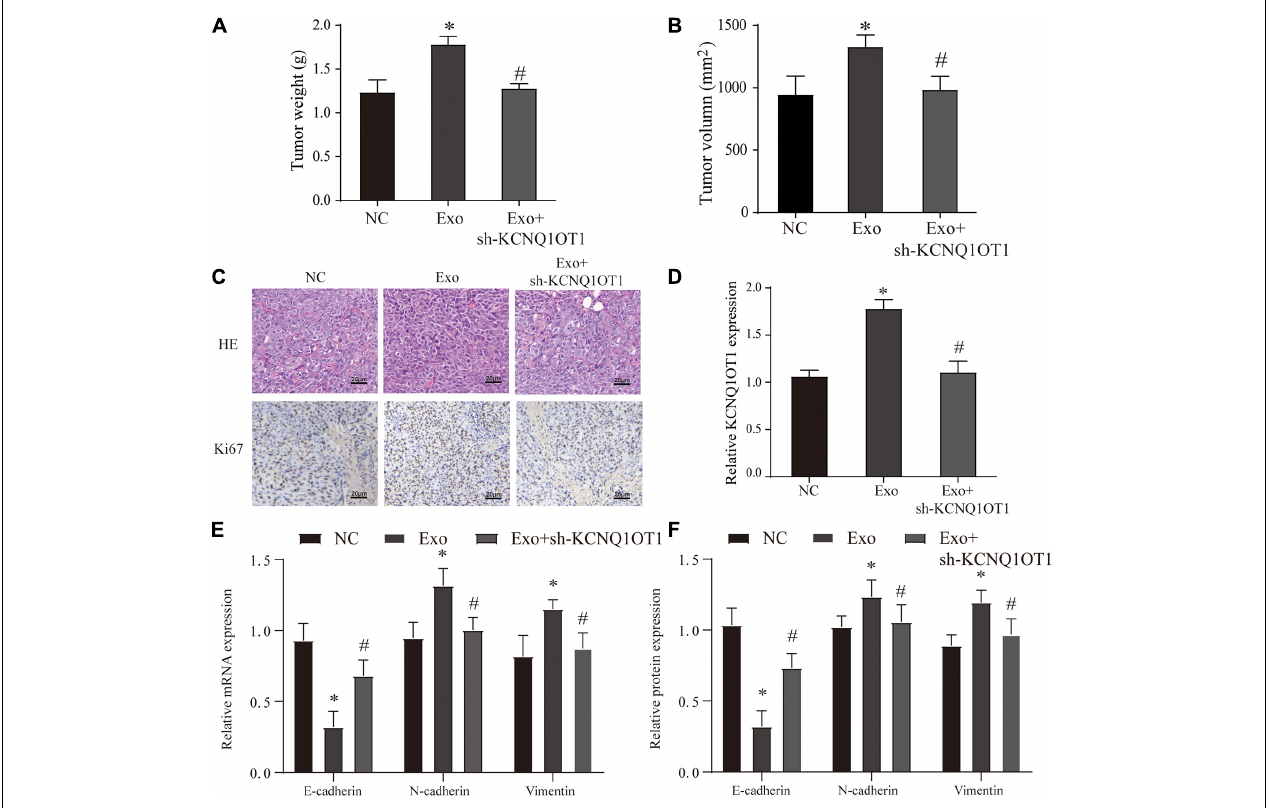
FIGURE 4 | Colorectal cancer (CRC)-derived exosomes promote the proliferation and invasion of CRC in the in vivo assay. (A,B) Tumor size and weight after different treatments in BALB/c nude mice. (C) H&E and Ki67 immunohistochemical staining were used to detect tumor proliferation in different groups. (D) The expression of KCNQ1OT1 in tumor tissues from different treatment groups. (E,F) Expression of epithelial–mesenchymal transition (EMT)-related genes and proteins. ∗ p < 0.05 compared with the NC group, # p < 0.05 compared with the Exo group, N =